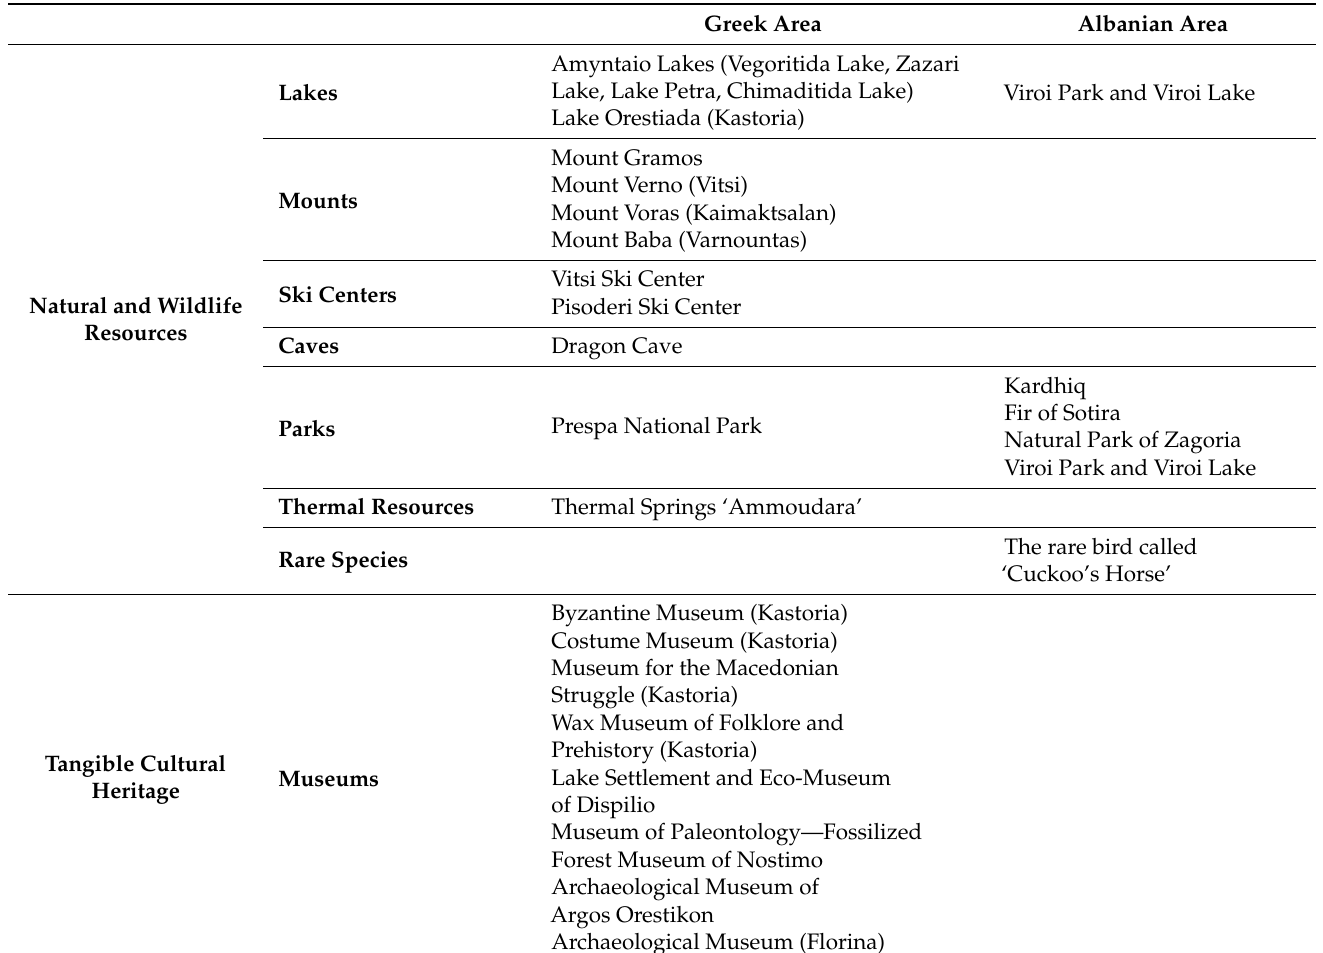
Table 4. Categorization of the final qualifying eco-cultural resources of the Greek–Albanian cross-border